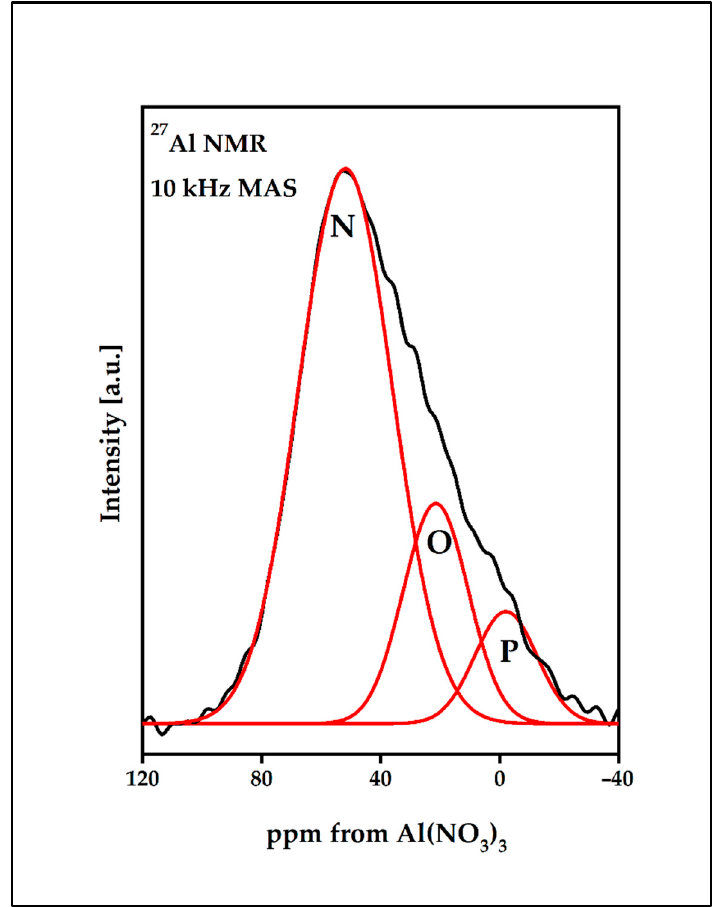
Figure 14. 27 Al MAS-NMR spectrum of BGG0.5Er_AlF 3 glass.